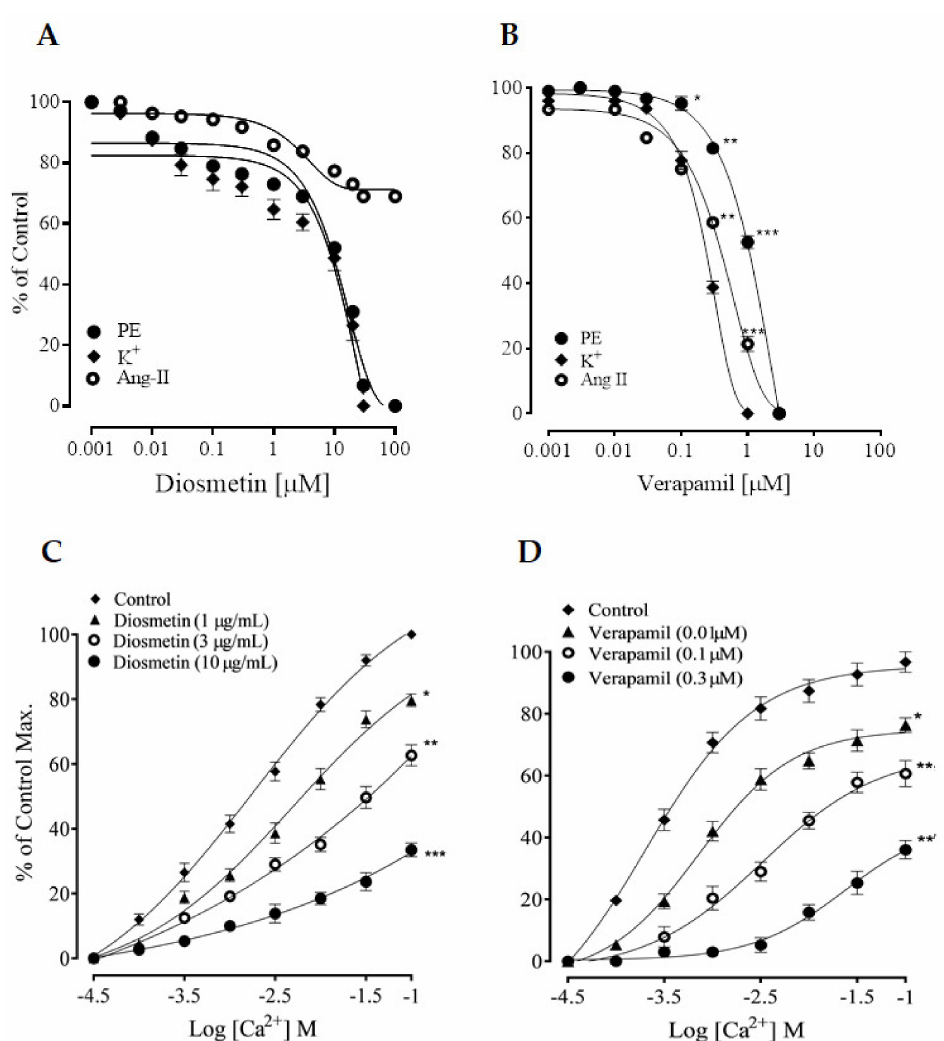
Figure 4. ( A , B )The vasorelaxant responses of diosmetin and verapamil to phenylephrine (PE), high K + and 5 µ M of Ang II; ( C , D ) the effects of diosmetin and verapamil on the calcium concentration response curves (CRCs) in a calcium-free medium using the aortic rings of rats. The relaxation and contractile responses are shown as means ± SEM ( n = 6). Significant differences vs. control: * p < 0.05; ** p < 0.01; *** p <